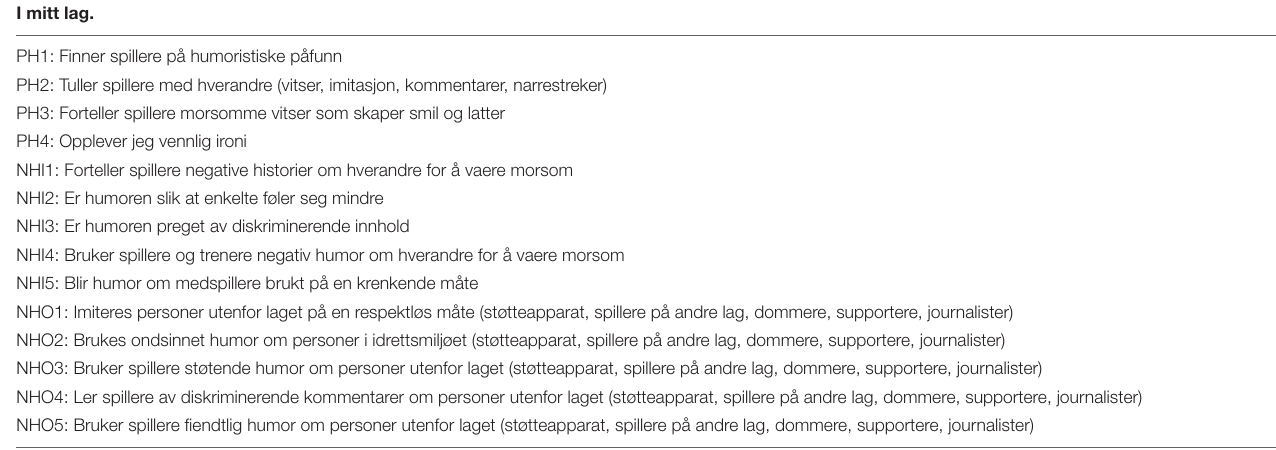
TABLE A1 | Norwegian version of the HCSS. I mitt